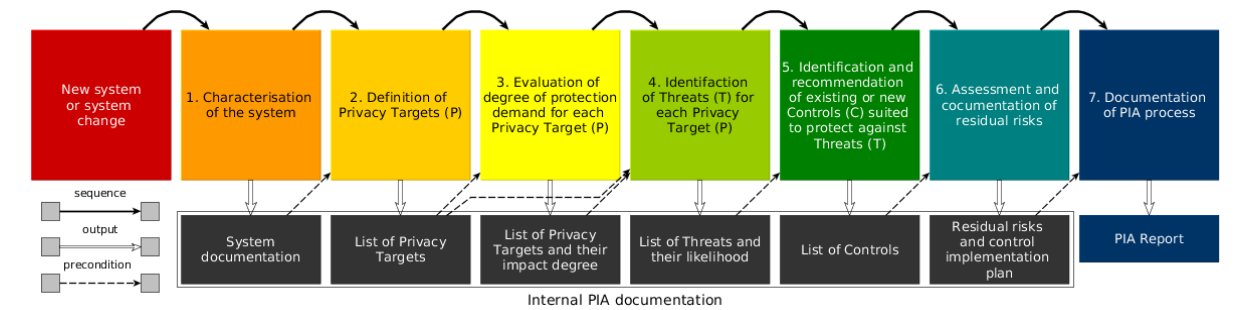
Figure 1. Privacy Impact Assessment (PIA) methodology